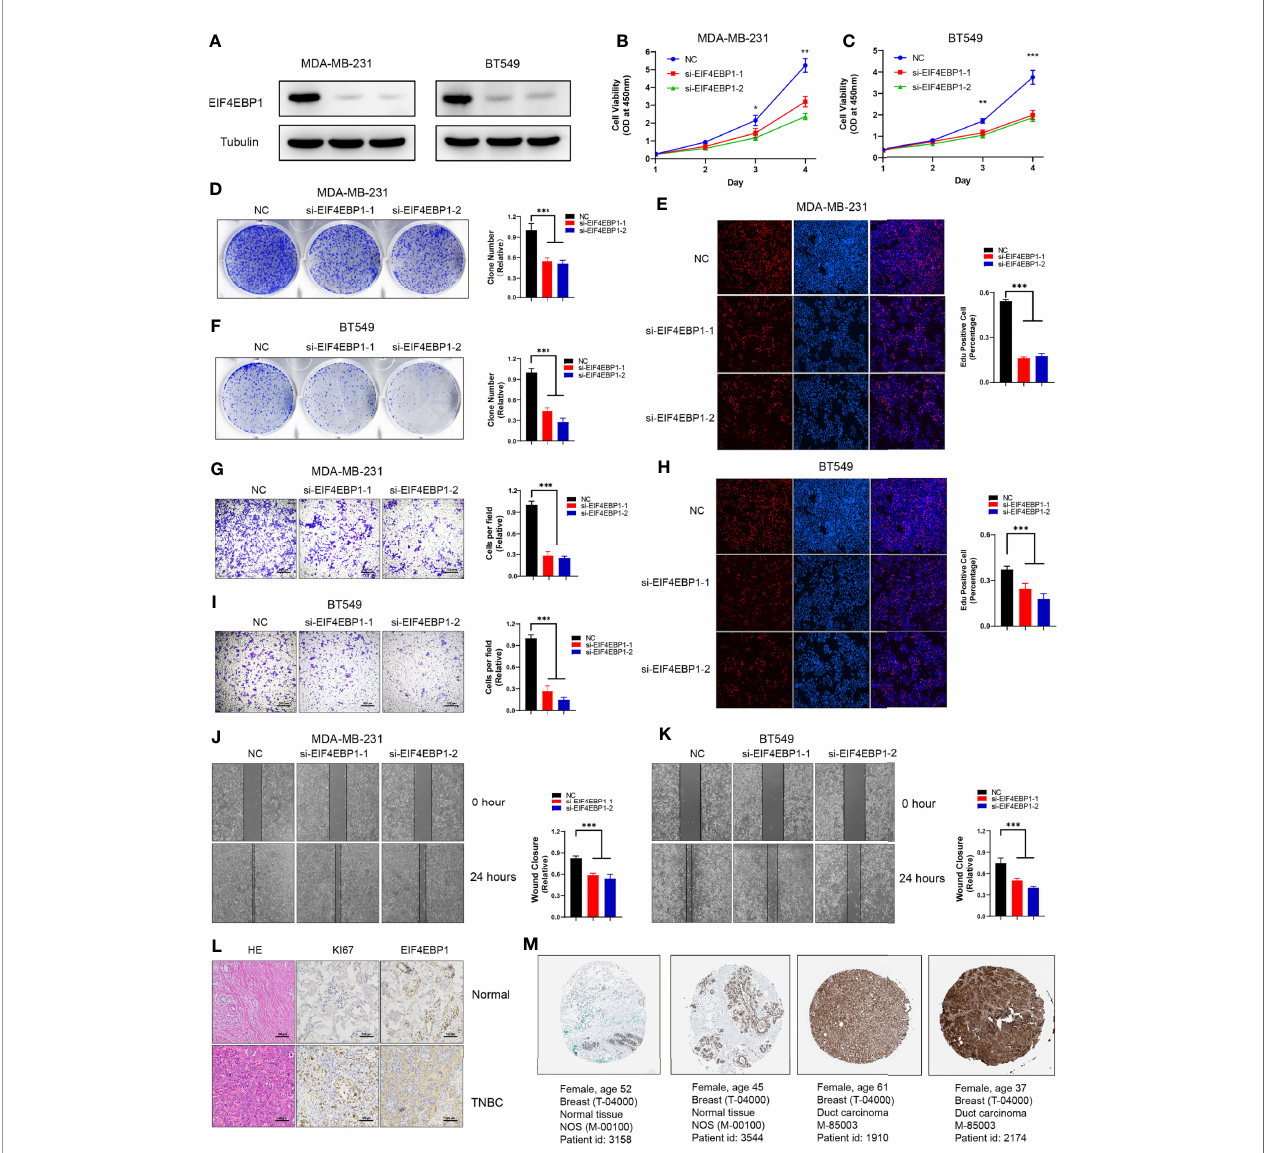
FIGURE 8 | EIF4EBP1 is required for TNBC cell survival and migration. (A) Western blot to show knockdown ef fi ciency of EIF4EBP1 in MDA-MB-231 and BT549 cells by two independent siRNAs. (B, C) Cell proliferation of MDA-MB-231 cells (B) or BT549 cells (C) transfected with control or EIF4EBP1 siRNAs was measured by CCK8. (D, F) Colony formation of MDA-MB-231 cells or BT549 cells transfected with control or EIF4EBP1 siRNAs was measured by ImageJ. (G, I) Transwell assay to show the cell metastasis of control cells compared to EIF4EBP1 knockdown cells. (E, H) Edu assay to show the cell proliferation of control cells comparing to EIF4EBP1 knockdown cells. (J, K) Wound healing assay to show the cell migration of control cells compared to EIF4EBP1-depleted cells. (L) Representative images of HE staining, immunostaining of KI67, and EIF4EBP1 in primary TNBC samples versus normal samples. (M) Representative images of immunostaining of EIF4EBP1 in primary TNBC samples compared to normal tissues from the HPA database. All data are shown as mean ± SEM. *p < 0.05, **p < 0.01, ***p < 0.001 by one-way